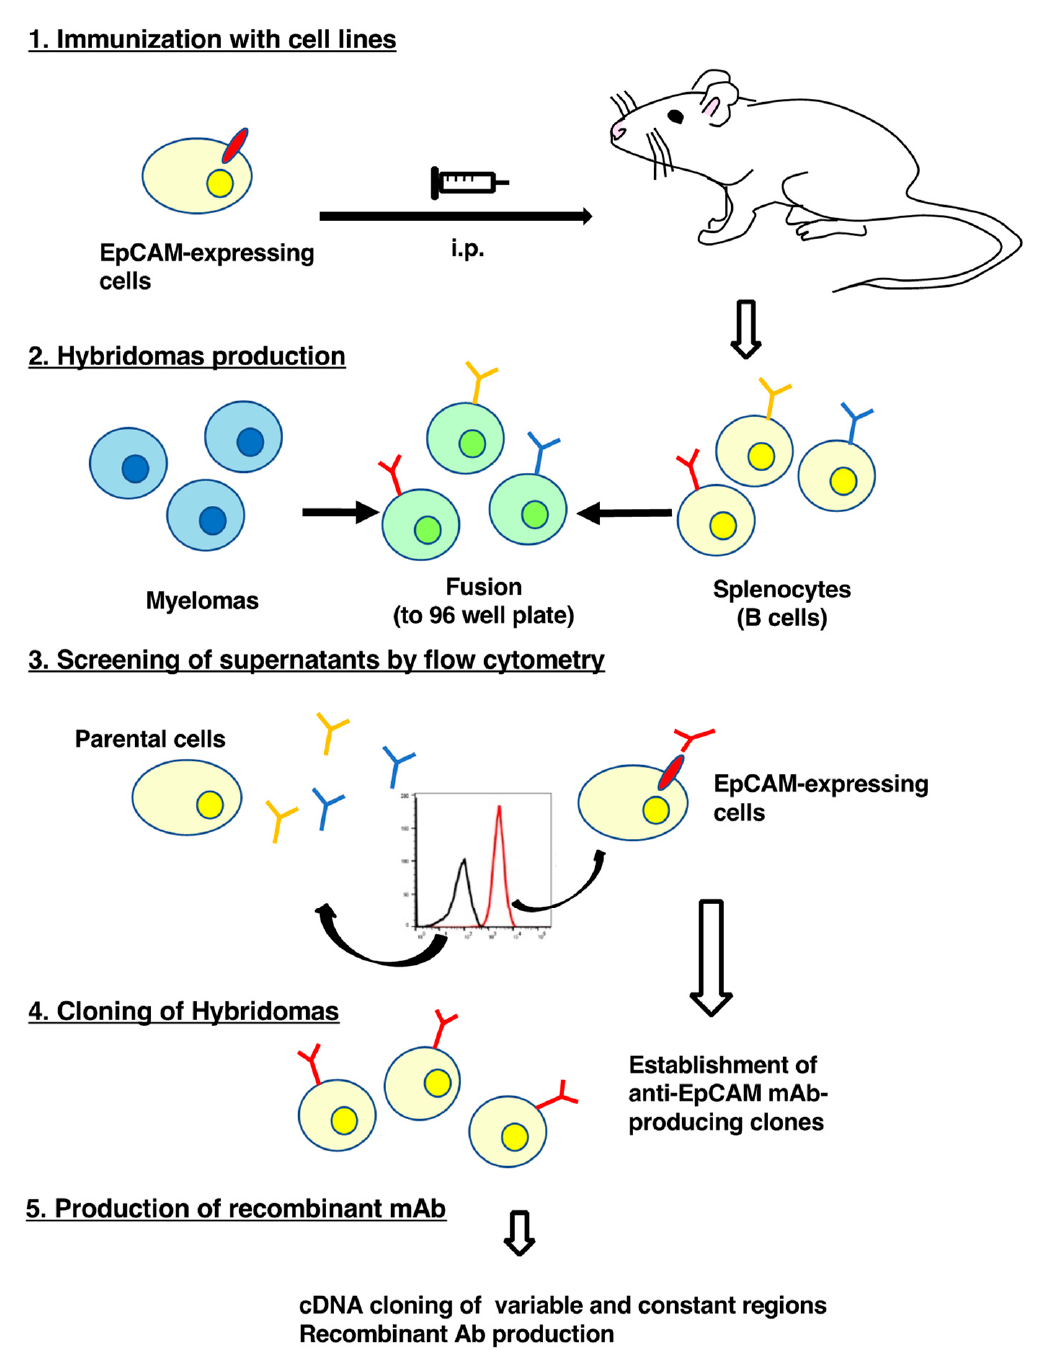
Figure 1. A schematic procedure of anti-EpCAM mAbs production. A mouse was intraperitoneally immunized with the CHO/EpCAM cells. The screening was then conducted by flow cytometry using parental cells and EpCAM-overexpressed CHO-K1 cells. Variable and constant regions cDNAs were cloned from an established clone, and the recombinant Ab was produced.